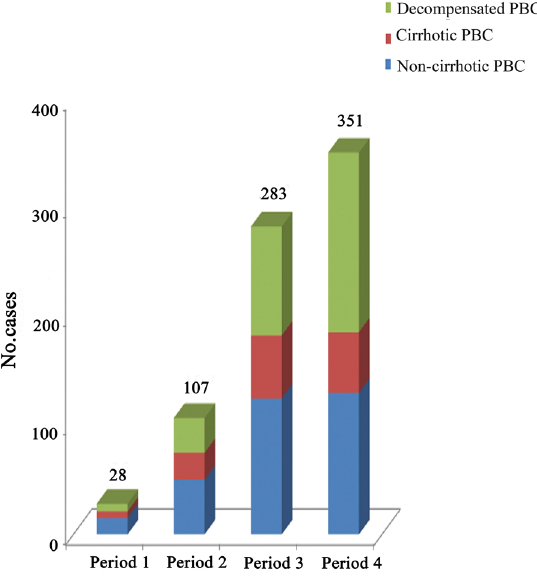
Figure 1. Time trends of PBC at different periods over the 16-year period from January 2001 to July 2016. The data were grouped over 4-year intervals.